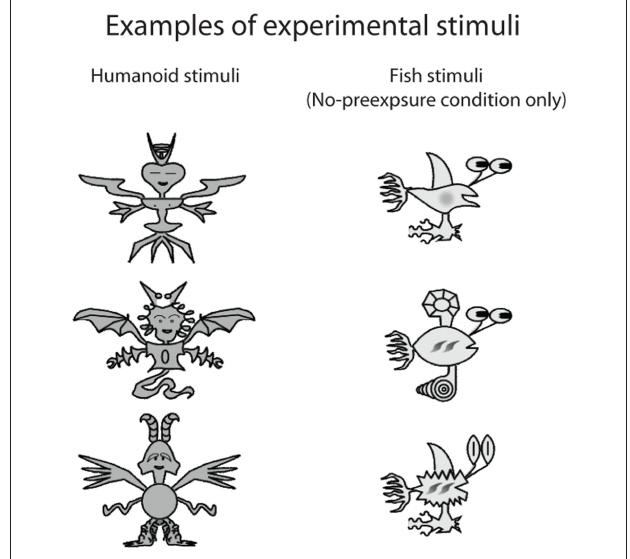
Figure 1 | examples of the objects. Full descriptions of the stimuli are shown in the